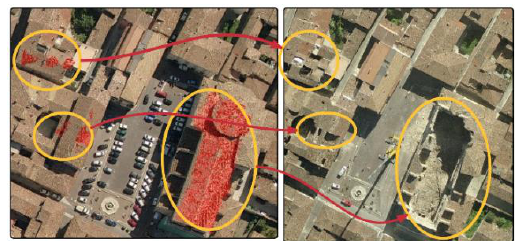
Figure 10. The detected missing pre-event segments using composite segment-based approach are projected as red points over a pre-event image (left), and outlined in the post-event (right) images with yellow circles.